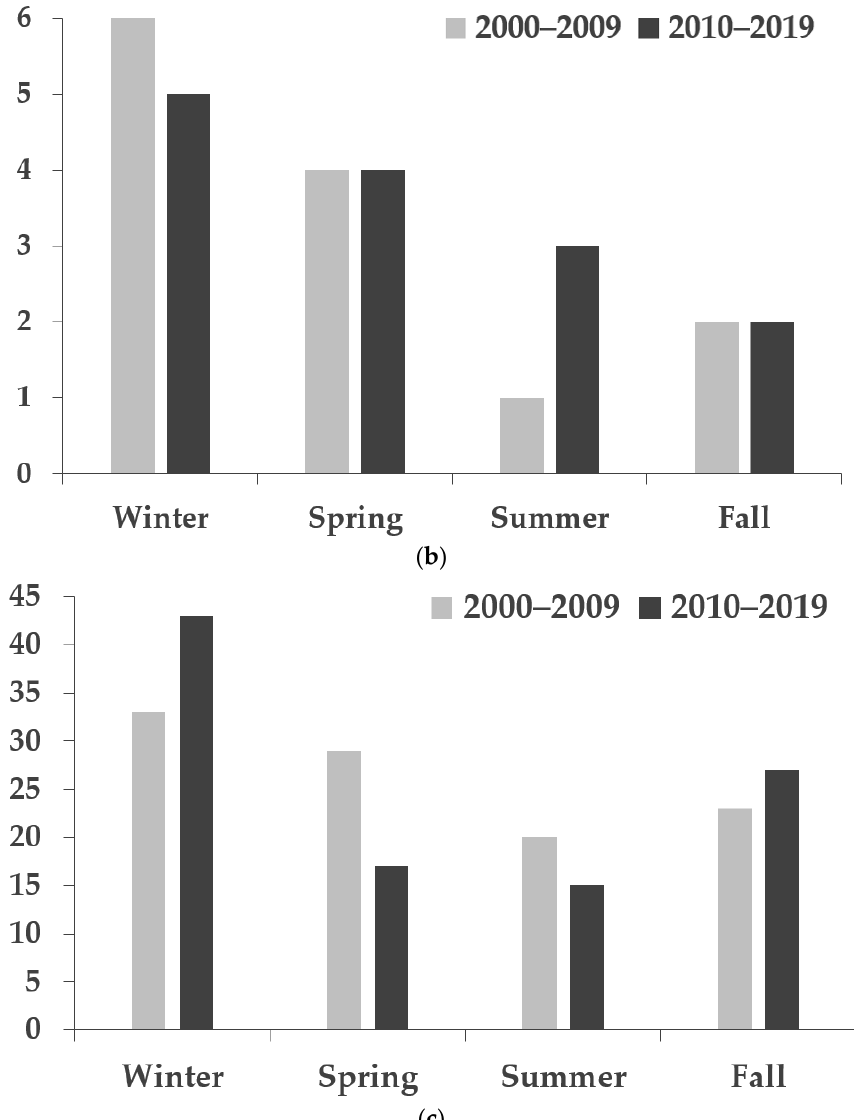
Figure 1. Seasonal distribution of patients with ( a ) preseptal cellulitis, ( b ) orbital cellulitis, and ( c ) preseptal plus orbital cellulitis.